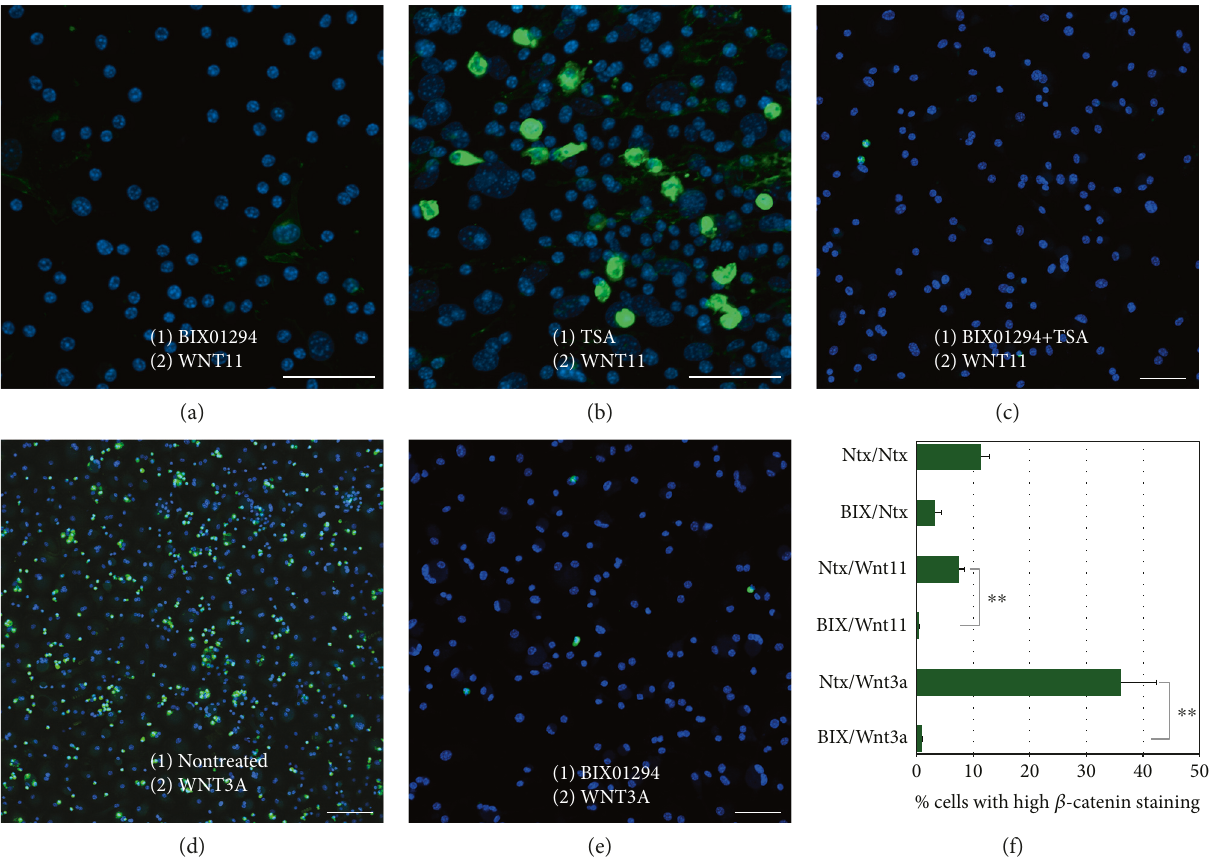
Figure 8: Di ff erential β -catenin immunoreactivity by MSCs cultured under various conditions. MSCs were fl uorescently labeled with β - catenin antibody (green) and DAPI nuclear stain (blue), after culturing cells for 2 days in the absence or presence of BIX01294 and/or TSA and for an additional 2 days with or without Wnt11 or Wnt3a. (a) MSCs cultured in sequence with BIX01294 and Wnt11 were de fi cient in cells that brightly stained for β -catenin. In contrast, (b) cultures treated sequentially with TSA and Wnt11 still displayed numerous brightly stained β -catenin-positive cells. (c) However, MSCs pretreated with both BIX01294 and TSA, followed by Wnt11 exposure, no longer displayed cells with high-intensity β -catenin immunoreactivity. (d) MSCs treated with Wnt3a showed a marked increase in β -catenin-positive cells. (e) Yet, this high-intensity β -catenin immunoreactivity disappeared when MSCs were fi rst exposed to BIX01294 prior to treatment with Wnt3a. Scale bar=50 μ m. (f) Tabulation of immuno fl uorescent cells under these various conditions veri fi ed that BIX01294 pretreatments decreased the number of brightly stained β -catenin-positive cells that were derived from the cultures. Statistical signi fi cance is indicated by ∗∗ p < 0 01